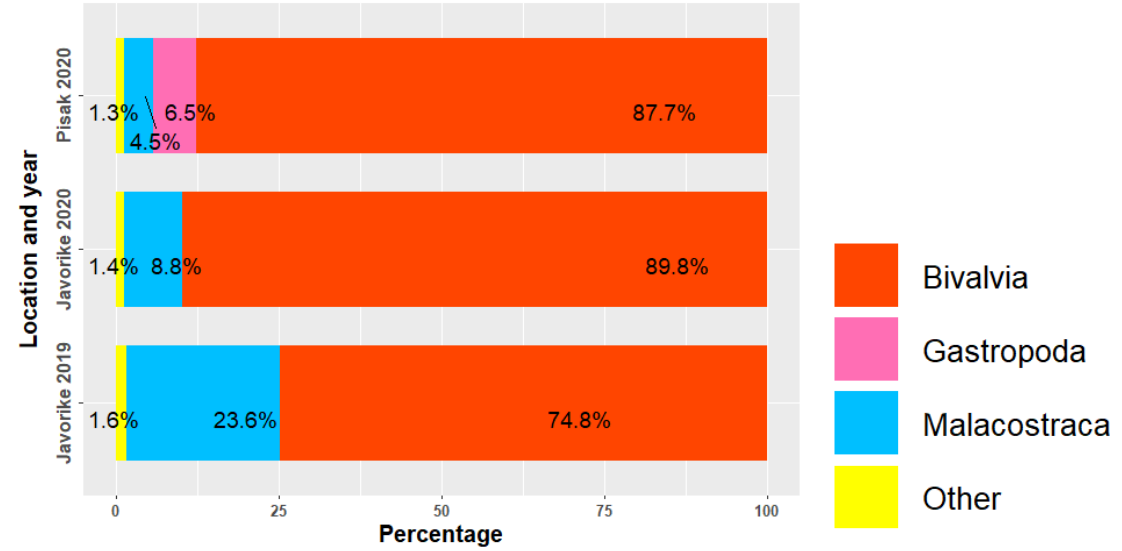
Figure 4. The proportion of different groups of organisms (in percentages) in the total number of organisms on larval collectors in Javorike and Pisak Coves in 2019 and 2020.